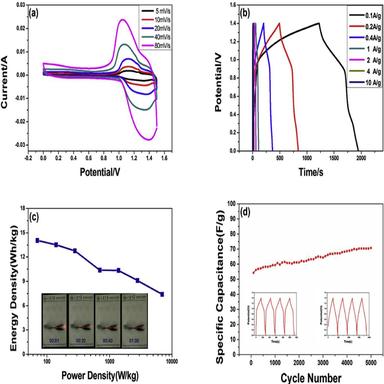
Electrochemical performance of ASC assembled using NFO/GNSs-10. (a) CV curves at various scanning speed and (b) GCD behaviors at different current densities; (c) plot of specific energy density and specific power density; (d) cycle life at current density of 0.5 A g1 , the inset is the charge-discharge curves for the first four cycles (left) and the last four cycles (right).